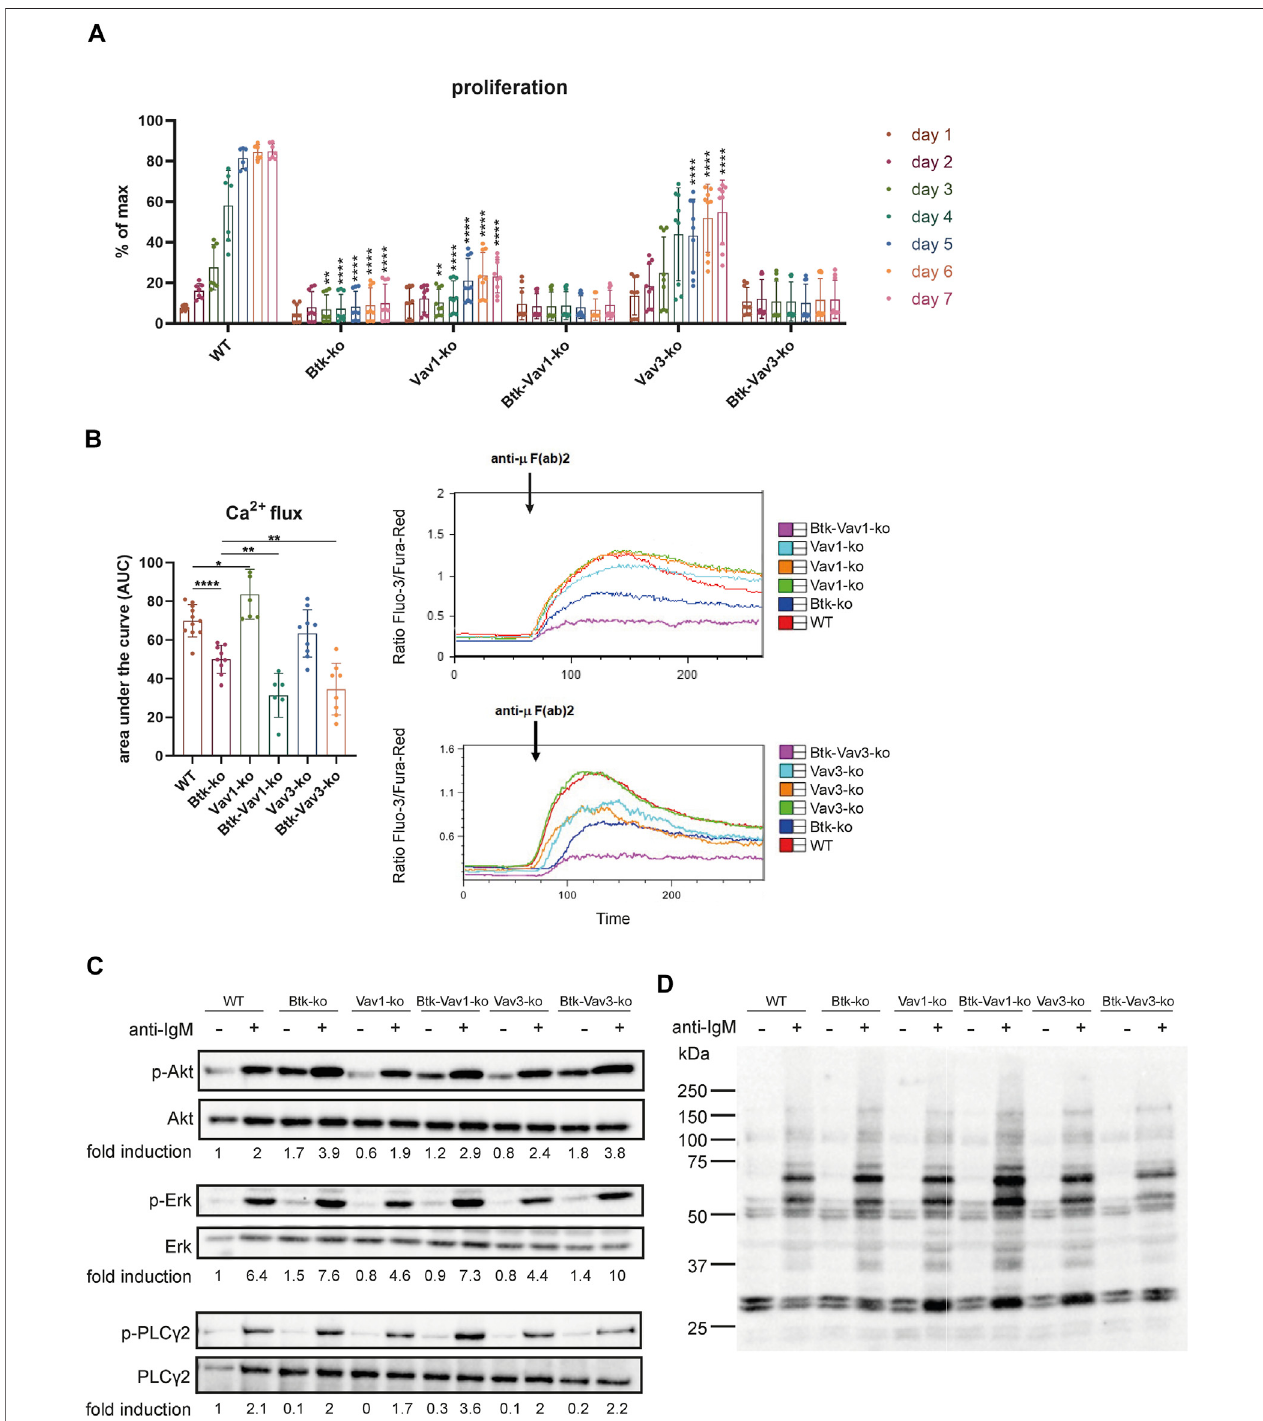
FIGURE 5 | Vav-protein de fi ciency affects B cell proliferation and exacerbates Ca2+ mobilization defects. (A) Statistical analysis of fl ow cytometry data showing CFSEdilutionofBcells.SplenocyteswerelabeledwithCFSEandproliferationofB220 + Bcellswasmonitoredover7days.Asterisksindicatesigni fi cancescomparedto WT control animals. (B) Statistics of Ca 2+ in fl ux showing the area under the curve upon anti-µ F (ab) 2 stimulation (left). Representative plots depicting Ca 2+ in fl ux over time after anti-µ F (ab) 2 stimulation are shown (right). Each point represents data from a single mouse. Data in the graphs are shown as means ± SD (n = at least 6 mice per group). Data are merged from three independent experiments. * p < 0.05, ** p < 0.01, *** p < 0.001, and **** < p 0.0001. p -values were determined using a two- tailedStudent ’ sttestorMann-Whitney-Utest. (C) NaïveBcellswereisolatedfromrespectivemousestrainsandstimulatedwithanti-µF(ab)2for3 min.Cellswerelysed andphosphorylatedformsofAkt(S473),Erk(Y204)andPLC γ 2(Y1217)aswellasphospho-tyrosinewereassessedbywesternblot.Non-phosphorylatedproteinswere used as loading controls. Representative image of 2 independent experiments. Mice were analyzed in an age range from 7 – 14 weeks